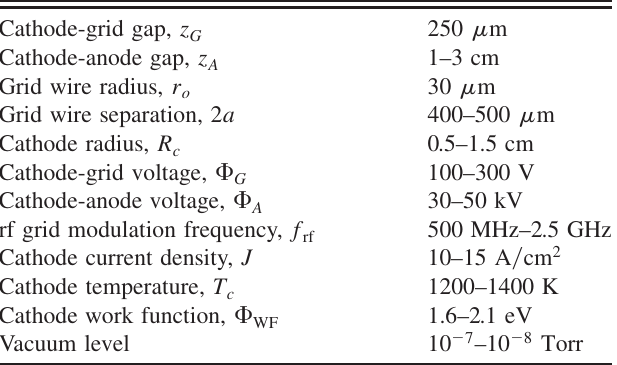
TABLE I. Typical range of parameters in an rf-gated, gridded thermionic gun in which a conventional dispenser cathode is